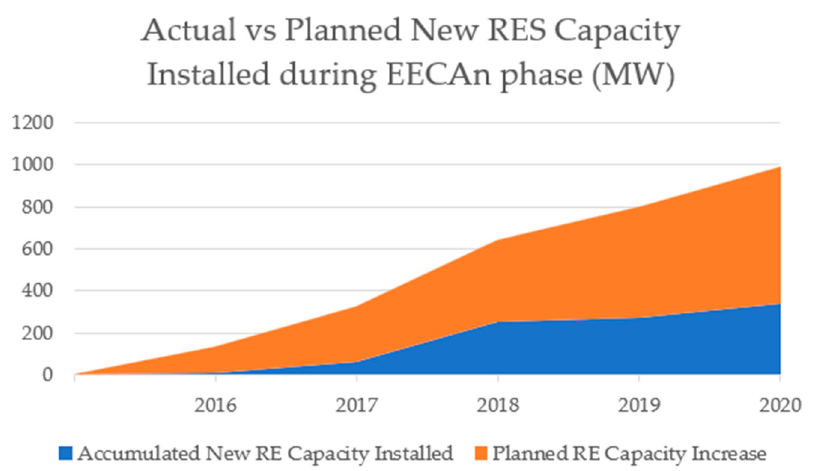
Figure 3. Yearly RES capacity installed (actual vs. planned) during the EECan phase 2020. Sources: Own elaboration sourced with the Canary Islands Yearbook .